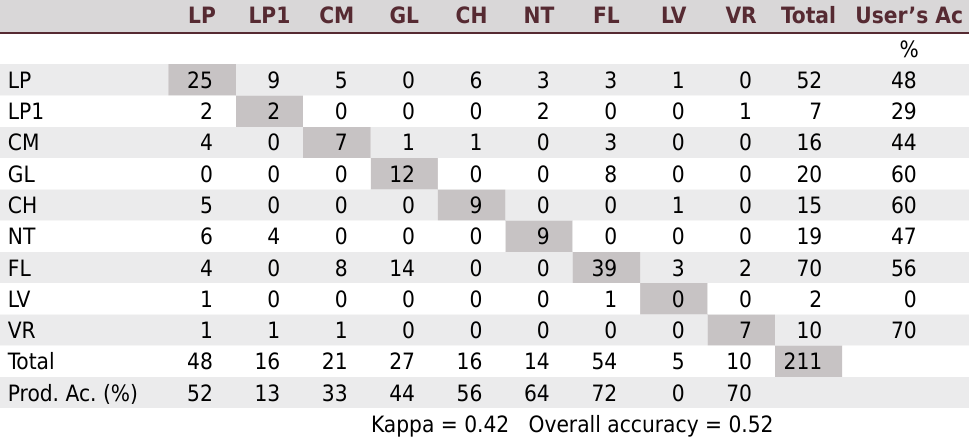
Table 3. Confusion matrix of soil classification using Random